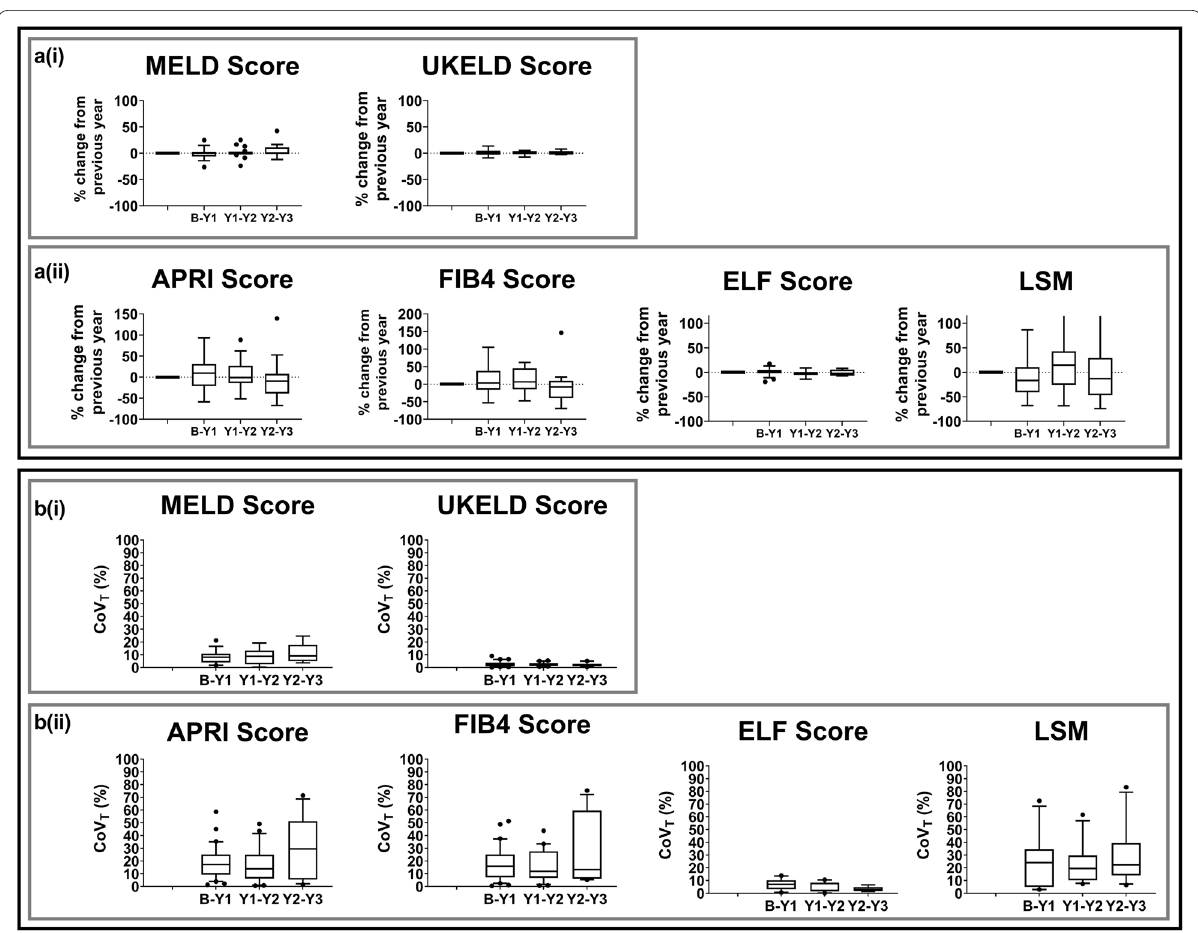
Fig. 3 a Year-to-year percentage change in clinical measures in the stable compensated cirrhosis control group. b Year-to-year coefficient of variation (CoV T ) in clinical measures in the stable compensated cirrhosis control group. Clinical measures of MELD, UKELD, APRI, FIB4, ELF scores, and Fibroscan ® LSM are shown. Bars indicate the interquartile range and the horizontal bold line shows the median, dots represent outliers. MELD Model for end-stage liver disease, UKELD United Kingdom model for end-stage liver disease, APRI Aspartate aminotransferase to platelet ratio index, FIB4 Fibrosis-4, ELF Enhanced liver fibrosis, LSM Liver stiffness